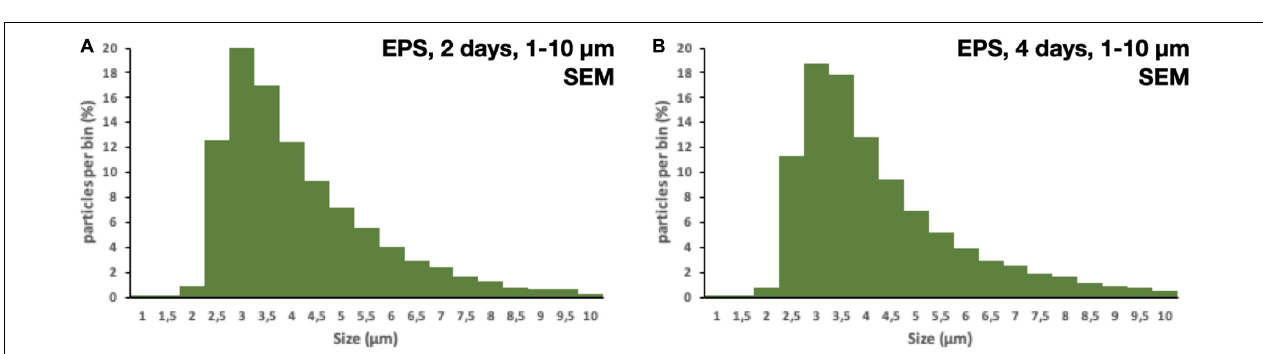
FIGURE 4 | Size distribution of particles collected on the 10 µ m filter after (A) 2 days of fragmentation, (B) 4 days of fragmentation, (C) blank samples after 2 days of fragmentation, and (D) blank samples after 4 days of fragmentation.